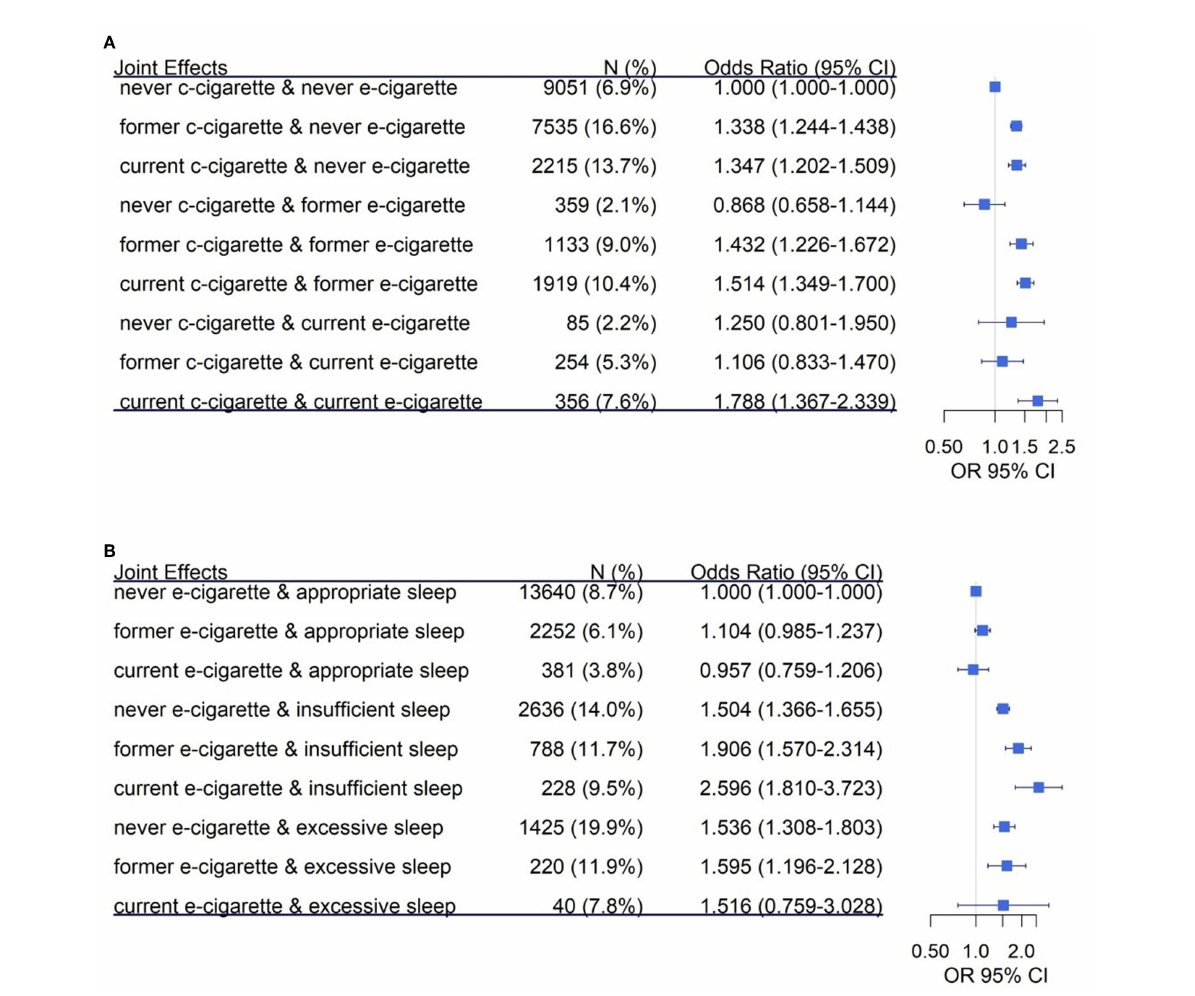
FIGURE2 The joint effect of electronic cigarettes with combustible cigarettes or sleep duration on the risk of CVD. The joint effect was analyzed by multivariable logistical regression, which was adjusted by sex, age, race, education levels, physical activity, chewing tobacco use, combustible smoking, body mass index (BMI), diabetes, depression, and COPD. (A) The joint effect of electronic cigarettes and combustible cigarettes on CVD. The reference group (A) is defined as the participants who never smoked electronic and combustible cigarettes. (B) Presents the joint effect of electronic cigarettes and sleep duration on CVD. The reference group (B) is defined as the participants who never smoked electronic cigarettes and had appropriate sleep duration. c-cigarette, combustible cigarette; e-cigarette, electronic